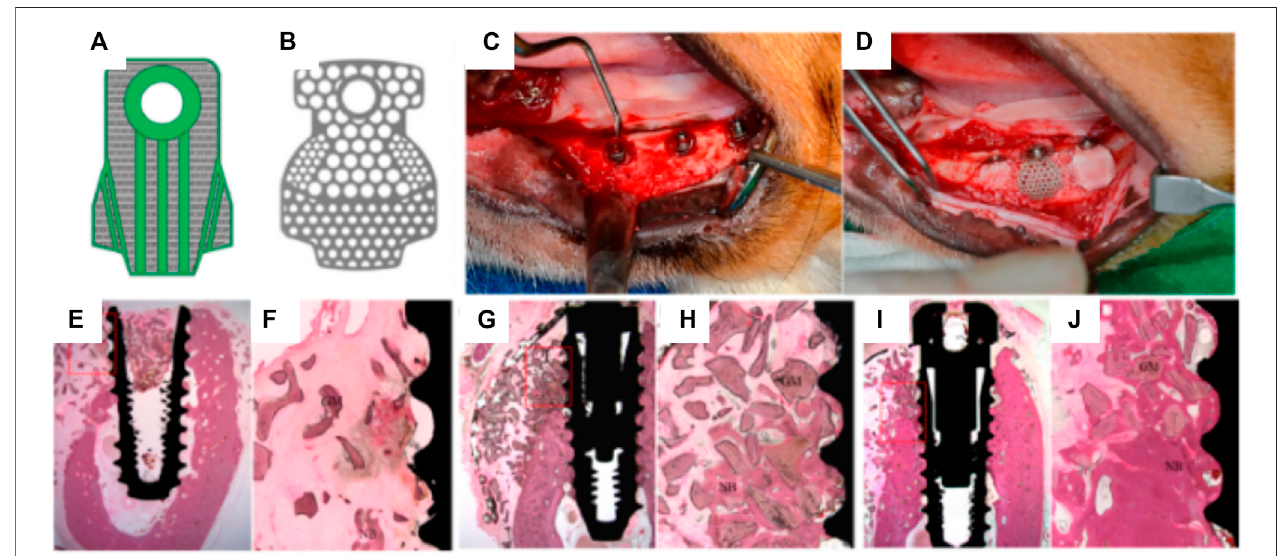
FIGURE9| Ef fi cacyof3D-printedcompositeGBRmembranesforboneformation8 weekspostimplantation. (A) :3DCADmodeldesignofthePCL/PLGA/ β -TCP membrane; (B) , Design of pre-formed titanium mesh. (C,D) : Surgical protocol showing the placement of dental implant overlayed by the 3D-printed membrane. (E – J) : tissue morphology of the various groups (E,F) : no membrane, (G,H) 3D-printed membrane, (I,J) : Titanium membrane. Reproduced with permission from (Shim et al., 2015).